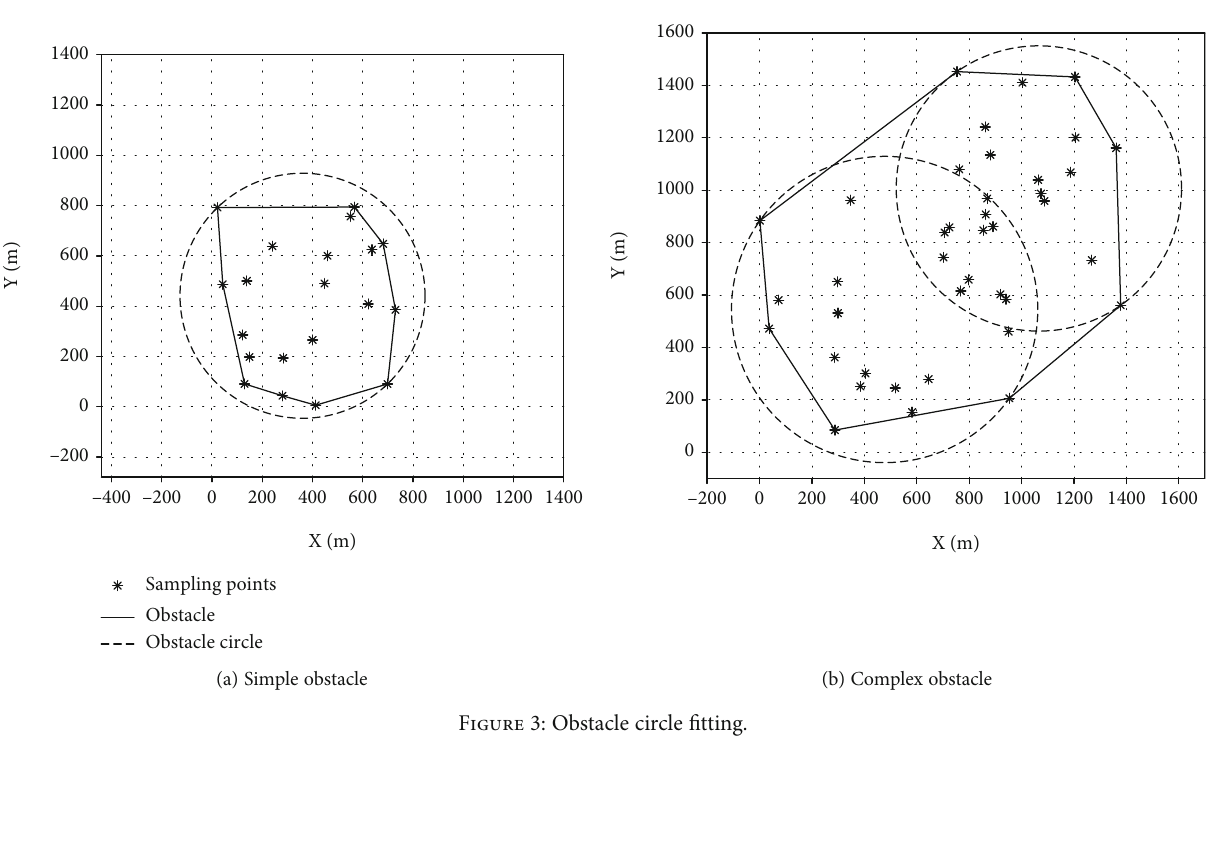
Figure 2: Obstacle